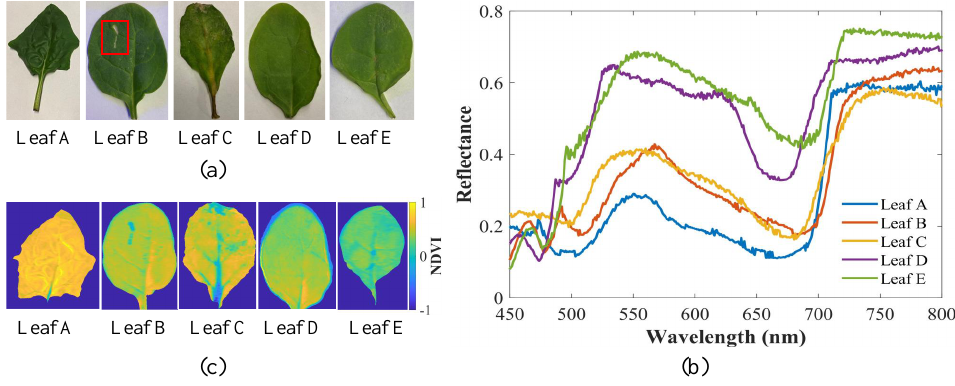
Figure 12. Reflectance and NDVI of spinach leaves at different fresh levels. ( a ) RGB images; ( b ) Re- flectance; ( c ) NDVI images. Pictures reprinted with permission from [55] © The Optical